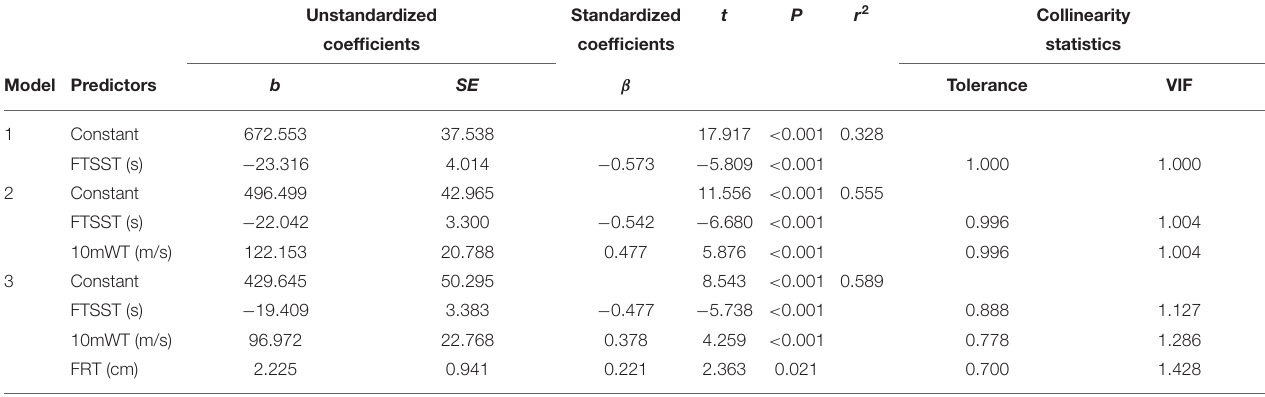
TABLE 3 | The result of multiple linear regression analysis coefficients in the healthy group a .